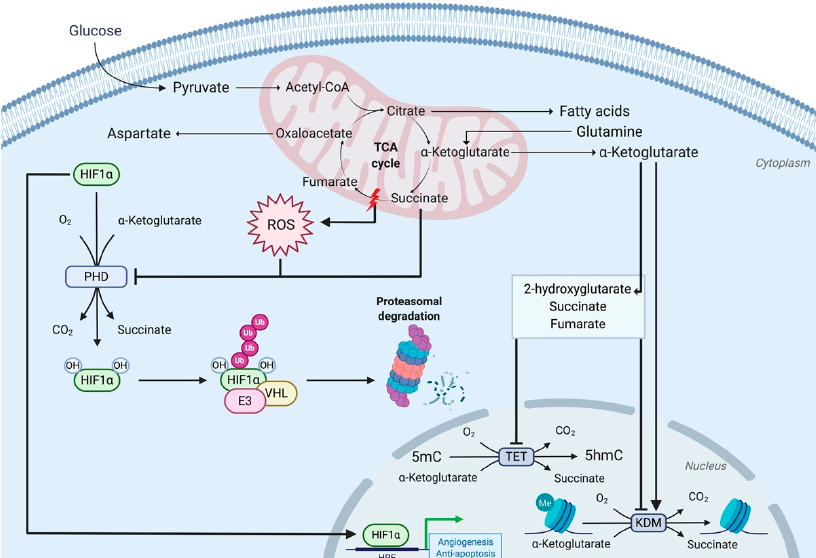
Figure 3. Role of TCA cycle intermediates in HIF1 α stabilization and nuclear epigenetic modifications.